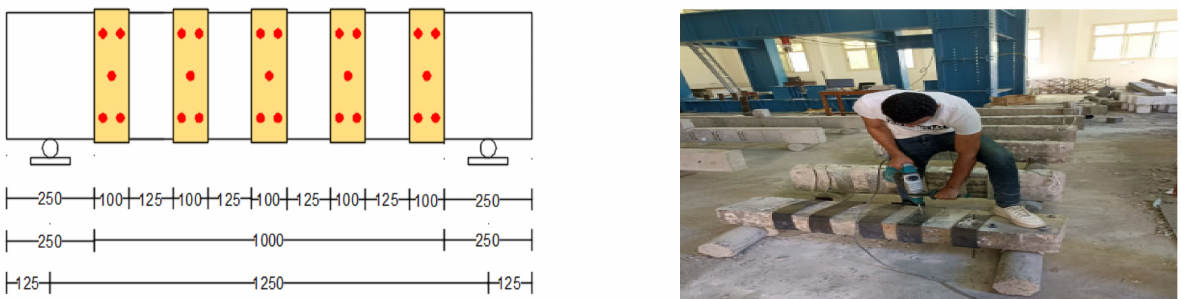
Figure 3. Preparing beam